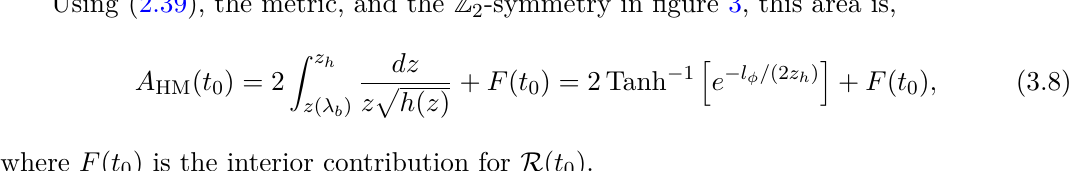
Figure 4 . The exterior of the planar BTZ at t = t 0 with the horizon at z = z h (in red) and a brane placed at φ = 0 (in blue), on which the 3-dimensional geometry induces an AdS the same horizon z = z . The Hawking radiation (depicted by a wavy arrow) is free to propagate h between the AdS black hole and the bath. We are interested in the swing surface corresponding 2 to the radiation region (in green, but technically including another interval on the other side of the